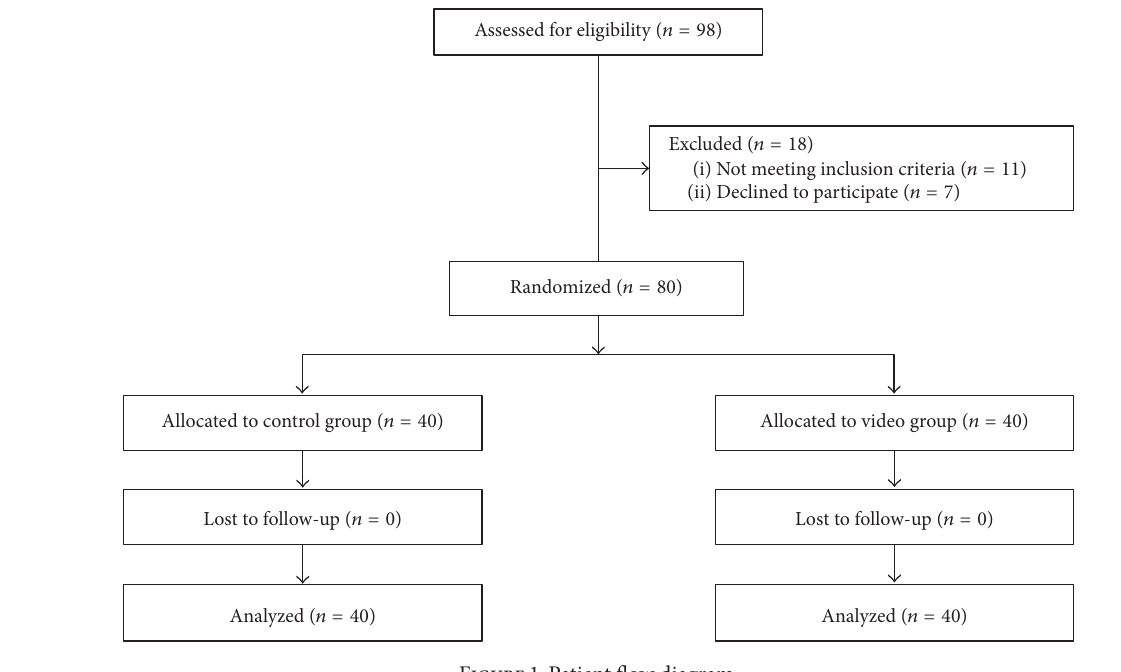
Figure 1: Patient flow diagram. Table 2: Patient satisfaction survey on the informed-consent